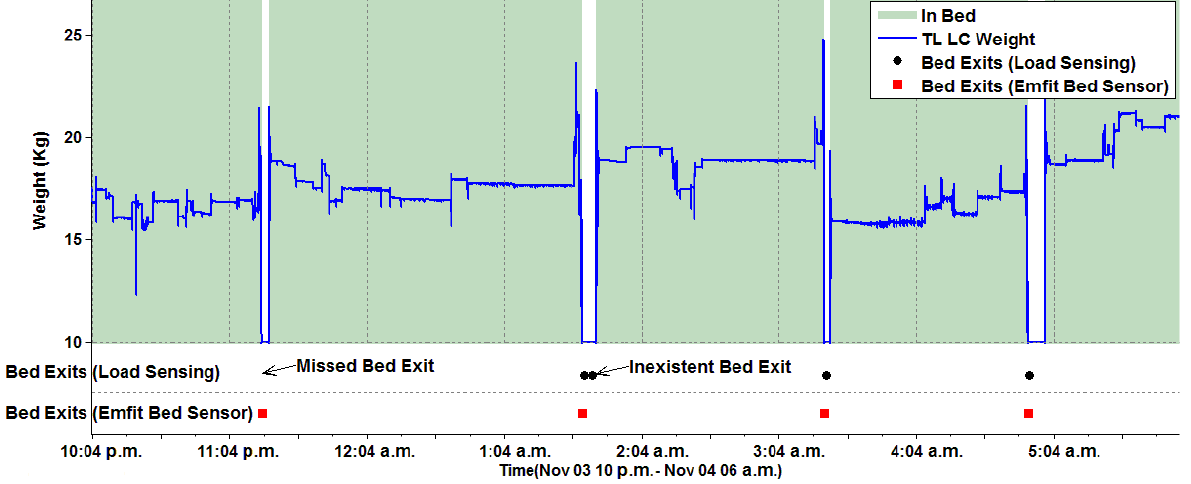
Figure 5. Bed entrances and exits are accurately detected by the active rule, while the bed-exit detection provided by the Emfit Bed Sensor misses bed exits or generates nonexistent bed exits. Because the sensors were active from 10 p.m. until 6 a.m., it was not possible to detect when the individual went to bed or when he left. TL LC denotes top-left load